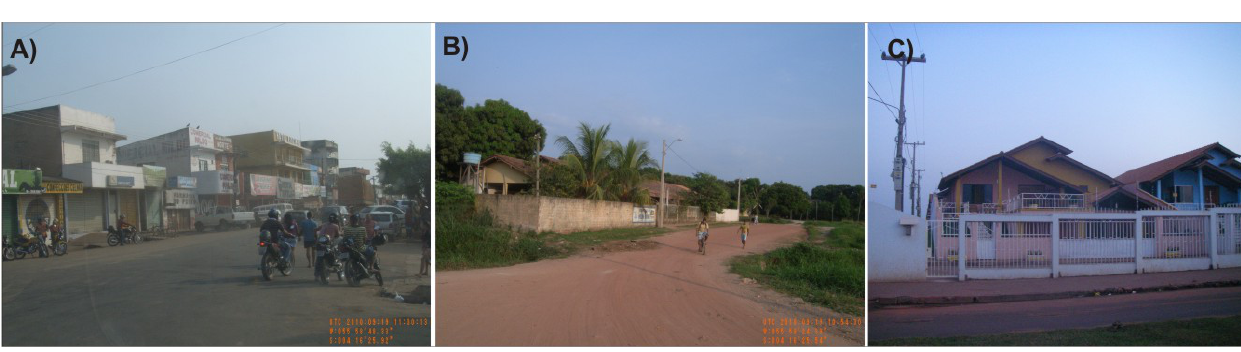
Figure 5. Spatial patterns verified within the units of human occupation that were categorized as Structured: ( A ) Itaituba-central commercial area; ( B ) Itaituba-sparse residential occupation and ( C ) Santarém-residential area with wealthy construction pattern.